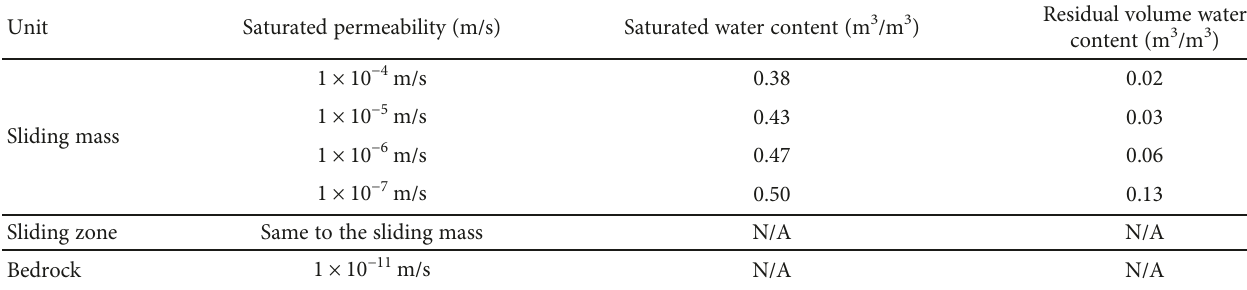
Table 3: Parameters related to the permeability of the landslide material.